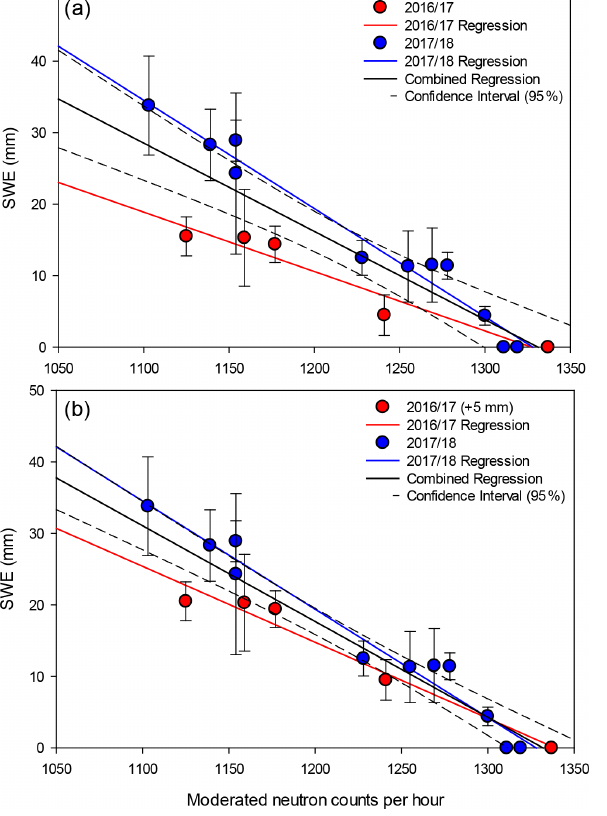
Figure 5. Comparison between counts ( N ) and average snow sur- vey SWE at the Elora site. Panel (a) shows both 2016/2017 and 2017/2018, with red and blue lines showing the regression Eqs. (6) and (7). Panel (b) shows 2016/2017 and 2017/2018 but with the re- gression equation for 2016/2017 SWE values adjusted to account for the antecedent water content in the top few centimeters of soil. The red line represents Eq. (7) and blue Eq. (8). Zero SWE val- ues represent snow-free conditions, and the error bars represent the standard